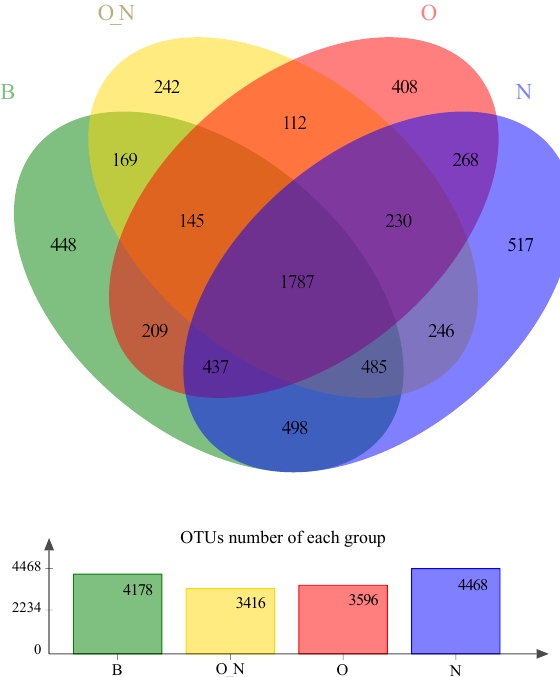
Figure 6. Venn diagram of representing the number on OTU level of groups B, N, O, and